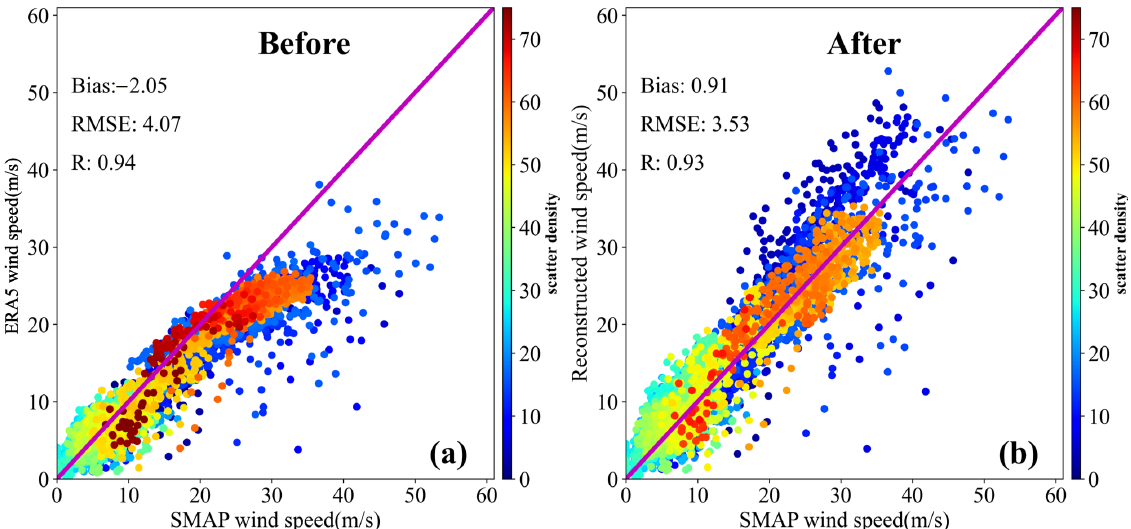
Figure 9. Comparison of wind field between before ( a ) and after ( b ) tropical cyclone reconstruction during the period from 2018 to 2020. The color scale is the number of data